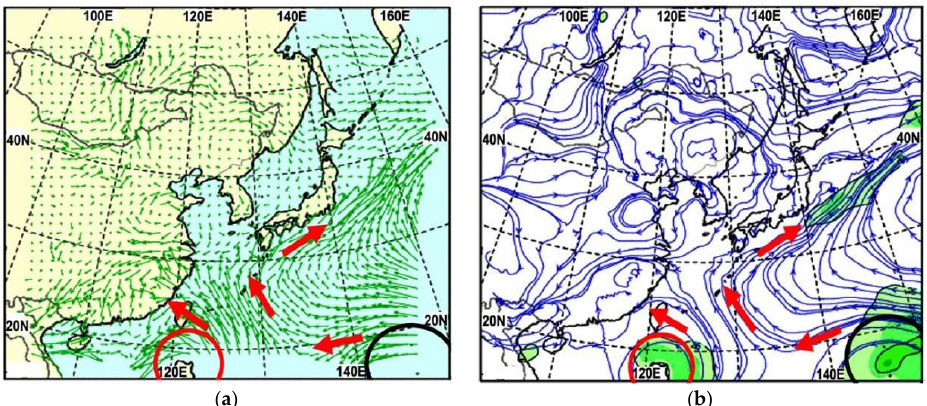
Figure 8. As shown in Figure 4, except for ( a ) moisture flux (0.1 kg ∙ ms − 1 ) and ( b ) streamline with isotachs at 09:00 LST, 5 July. As the MLCT steered both STS Linfa and TY Chan-Hom northward, their cyclonic circulations in their upper quadrants enabled intensification from the strong southwest wind produced by the MLCT, and the decreasing distance between them then enhanced the exchange of moisture.